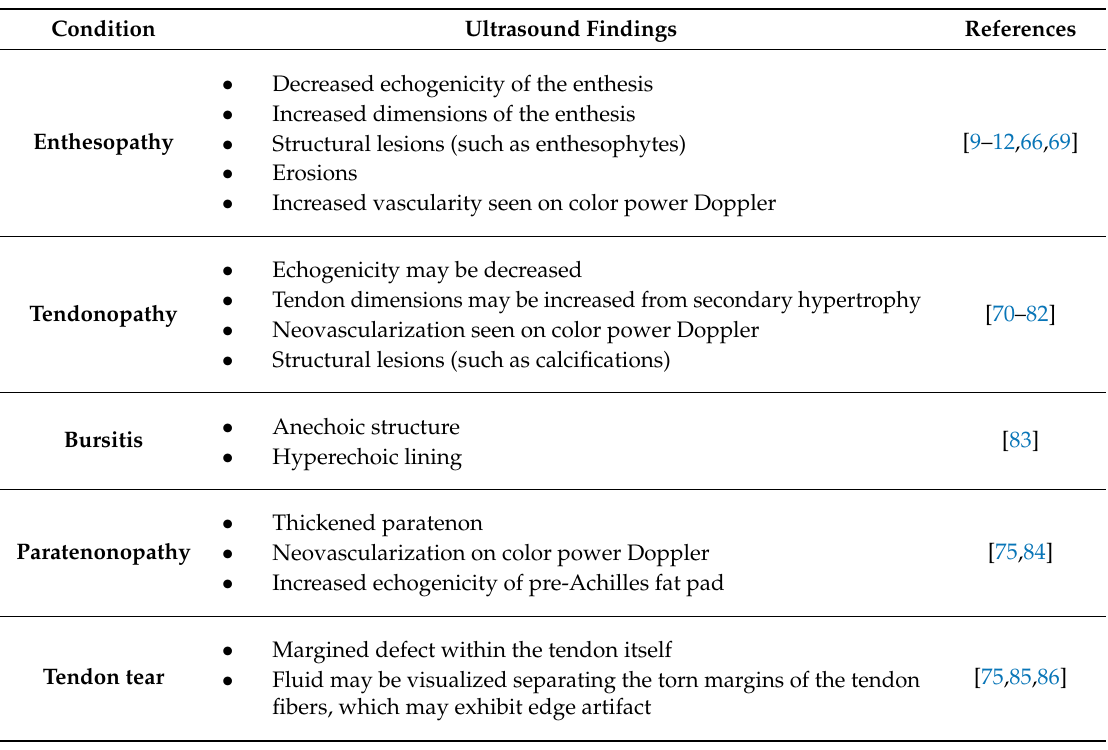
Table 2. Ultrasound findings for Achilles tendon